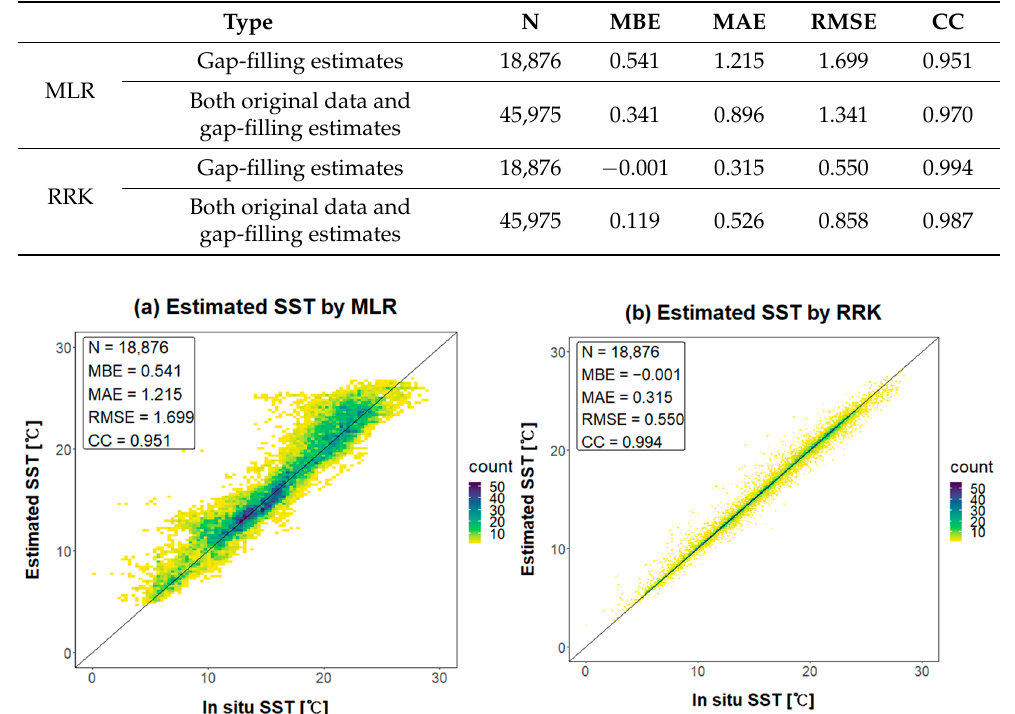
Figure 12. Scatter plots for the in situ SST and estimated SST by ( a ) MLR, and ( b ) RRK. The number of validation (N = 18,876) is for the pixels where GK2A had null values, and the in situ measurements existed in 2020.